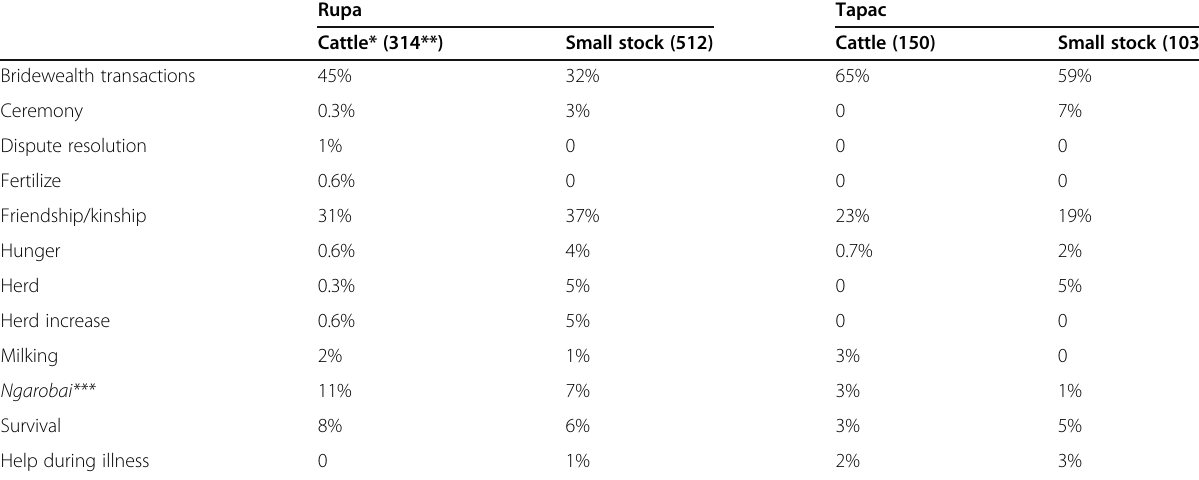
Table 2 Animals exchanged between stock friends in field sites by major categories (rounded %)